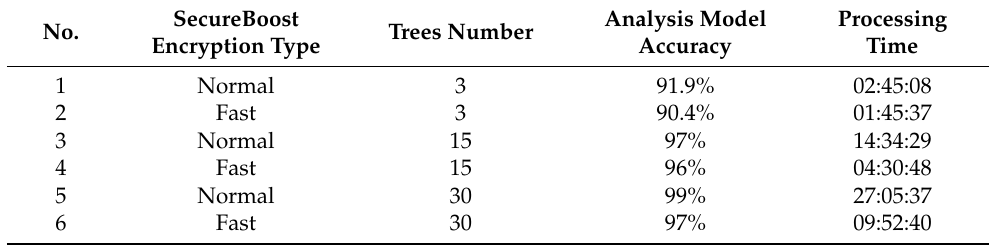
Table 2. The parameters of the intrusion detection model training when training in federated mode. No.